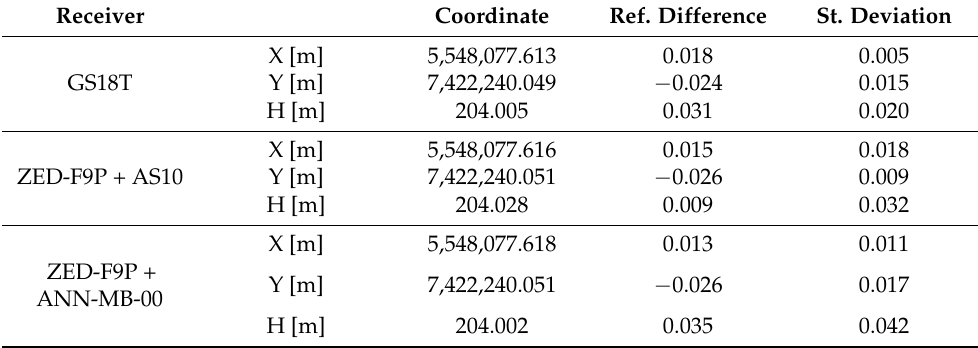
Table 6. Measurement results on Pt 5.